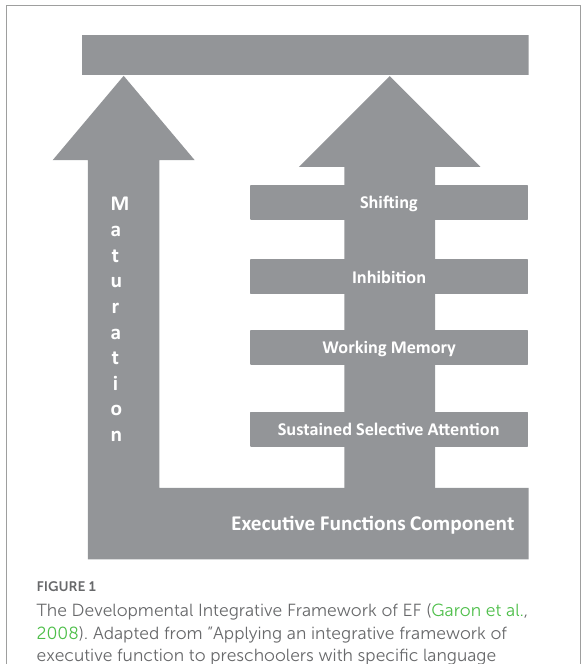
FIGURE1 The Developmental Integrative Framework of EF (Garon et al., 2008). Adapted from ”Applying an integrative framework of executive function to preschoolers with specific language impairment”, by Kapa et al., 2017, Journal of Speech, Language, and Hearing Research, 60(8), p.